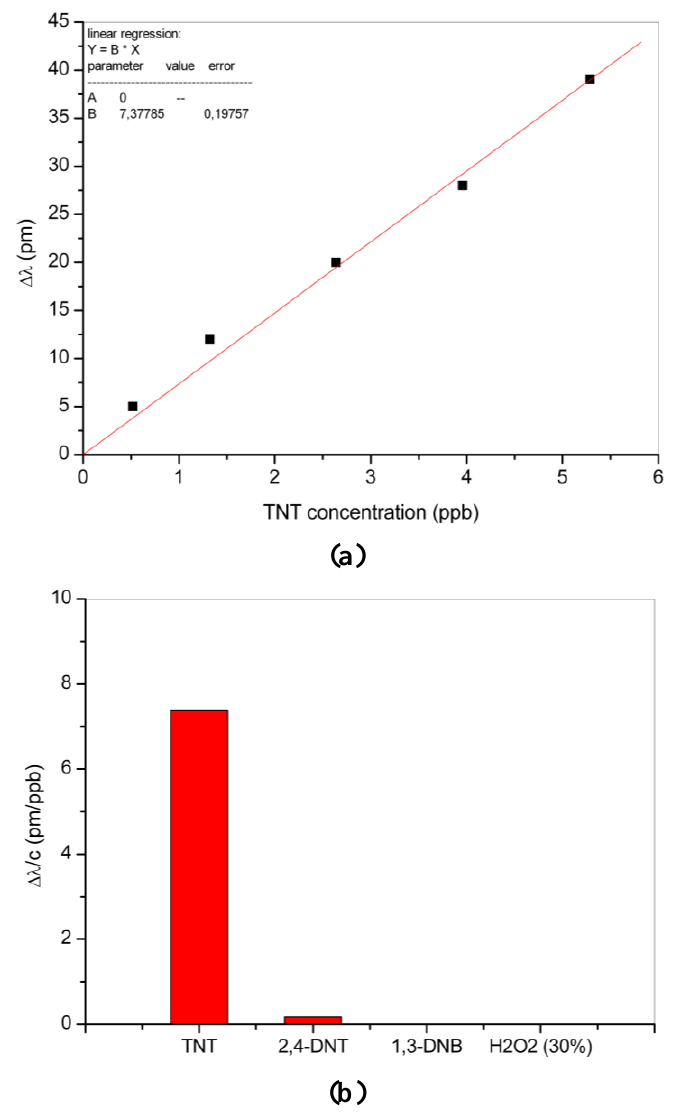
Figure 5. Wavelength shift of resonance measured for different concentrations of TNT (a); response of the sensor to TNT and other potentially interfering analytes